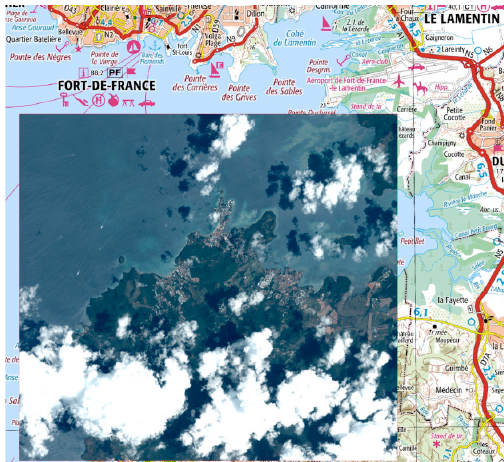
Figure 4. Initial Pléiades-HR ortho-image (depicted here in a RGB mode) and its localisation in the French West